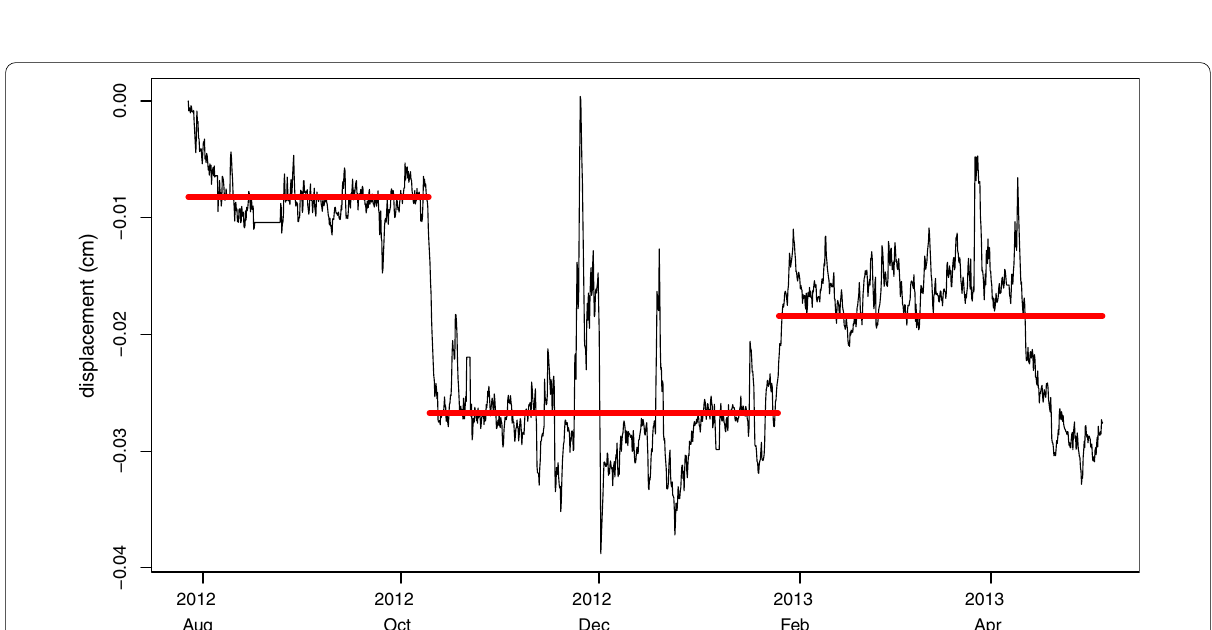
Fig. 6 Data series in the third phase after applying the changepoint method in R software. This phase runs from July 4, 2012 to April 11,